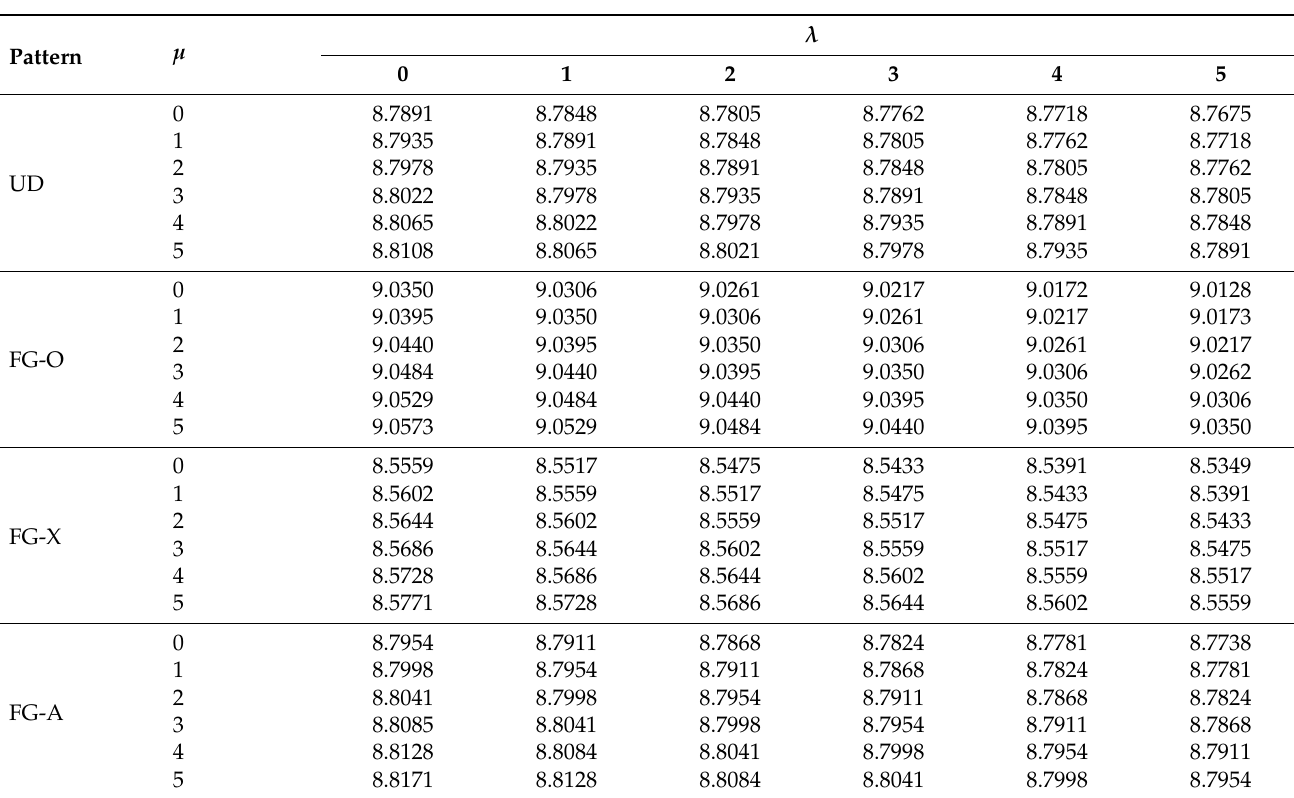
Table 11. Effect of nonlocal and small-scale parameters on dimensionless central deflection of